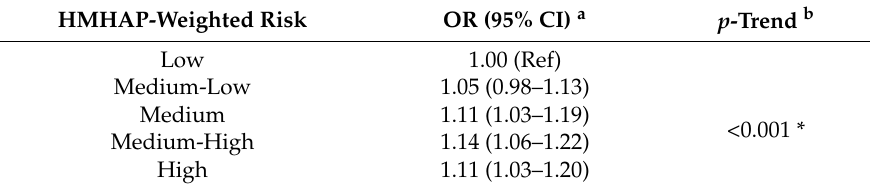
Table 3. Odds Ratios (95% CI) for associations between HMHAP-weighted risks and